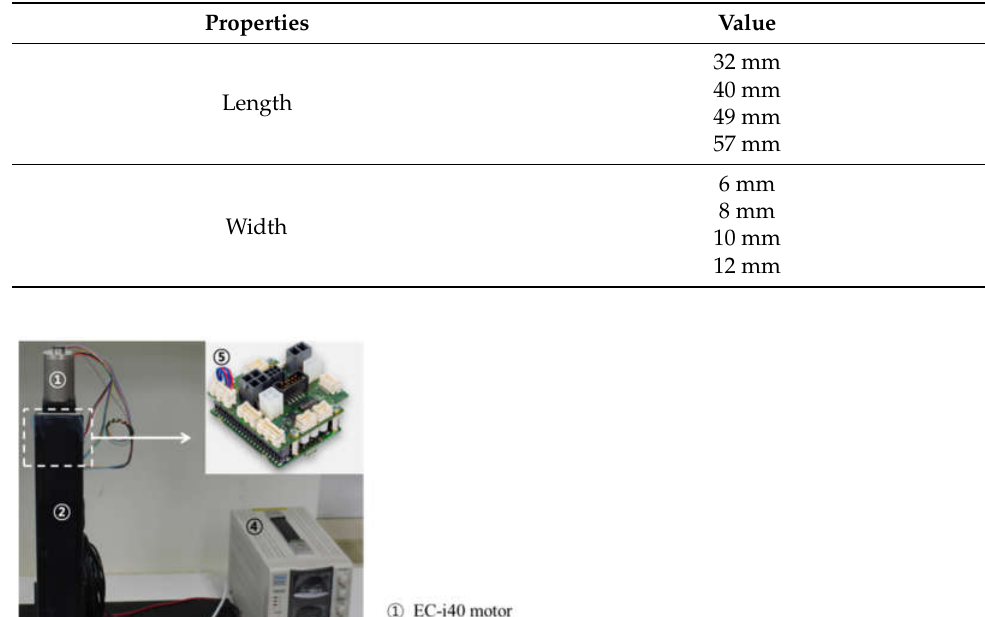
Table 2. Dimensions of the sensors.